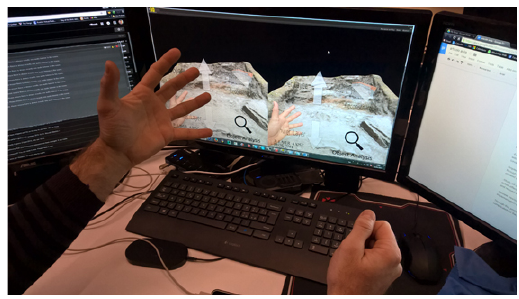
Figure 10. Snapshot of the study of the user behaviour - Review: revision of gestures based on user experience and new cycle evaluation, implementation and study of user behaviour.